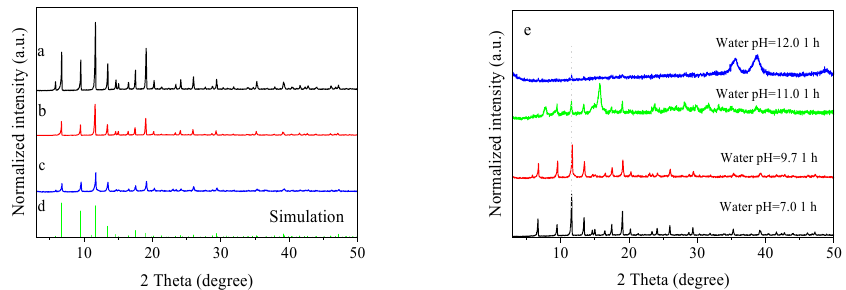
Figure 2. The X-ray diffraction (XRD) patterns of HKUST-1 ( a ), TEBAC-HKUST-1 ( b ), five cycles. (pH = 8.0) ( c ), the simulated sample of HKUST-1 ( d ), and TEBAC-HKUST-1 metal organic resin (MOR) at different pH values ( e ).